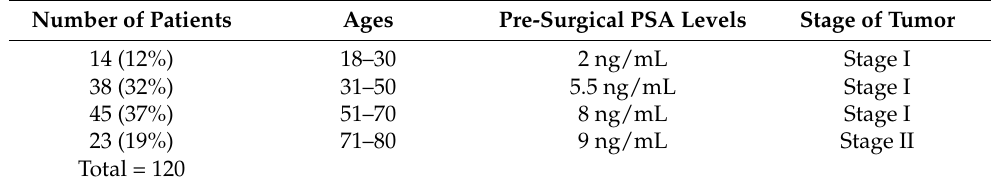
Table 7. Distribution of age comparison, PSA and stages of tumor in percentage (100%) in group B. Number of